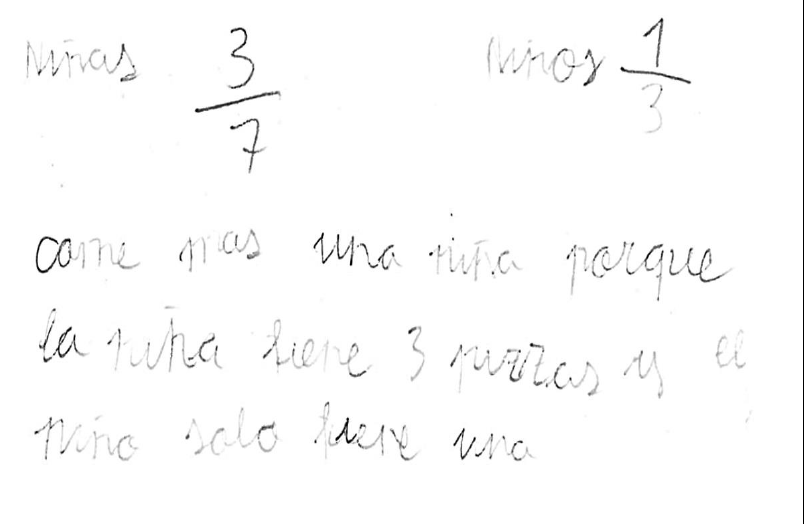
Figure 9. Solution to the task combining symbolic and verbal